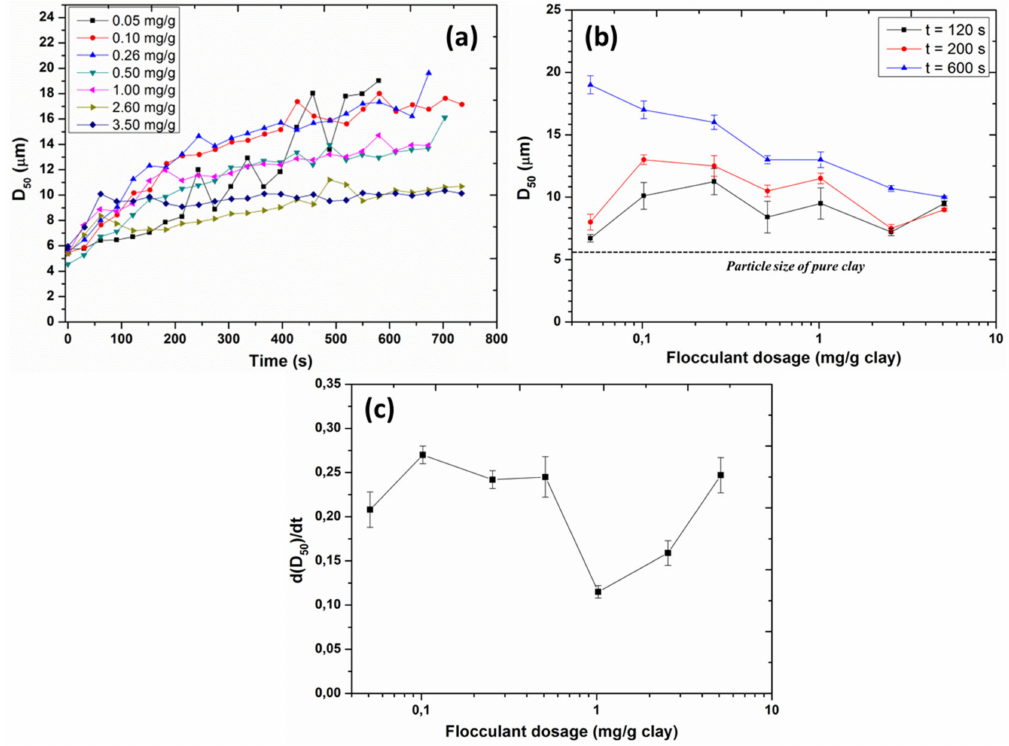
Figure 4. ( a ) Evolution of D 50 as a function of time for clay concentration of 0.7 g / L with di ff erent concentrations of anionic flocculant, ( b ) evolution of D 50 as a function of flocculant to the clay ratio (mg / g), and ( c ) dD 50 / dt as a function of flocculant to the clay ratio (mg / g). Bars represent standard